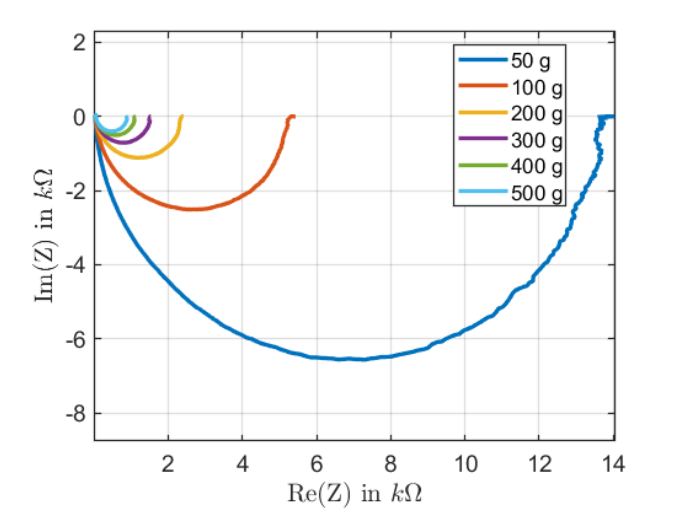
Figure 5. Nyquist plot for sample 2 with weights from 50 g to 500 g.